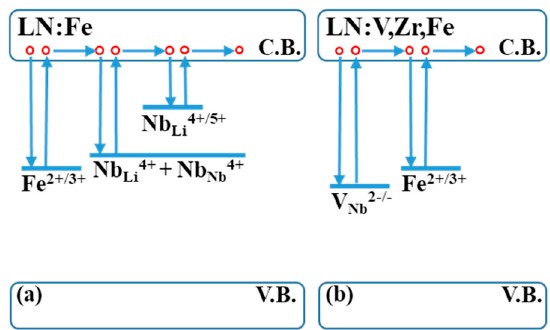
Figure 5. Schematic energy level diagram for ( a ) LN:Fe and ( b ) LN:V,Zr,Fe with intrinsic and extrinsic defects.